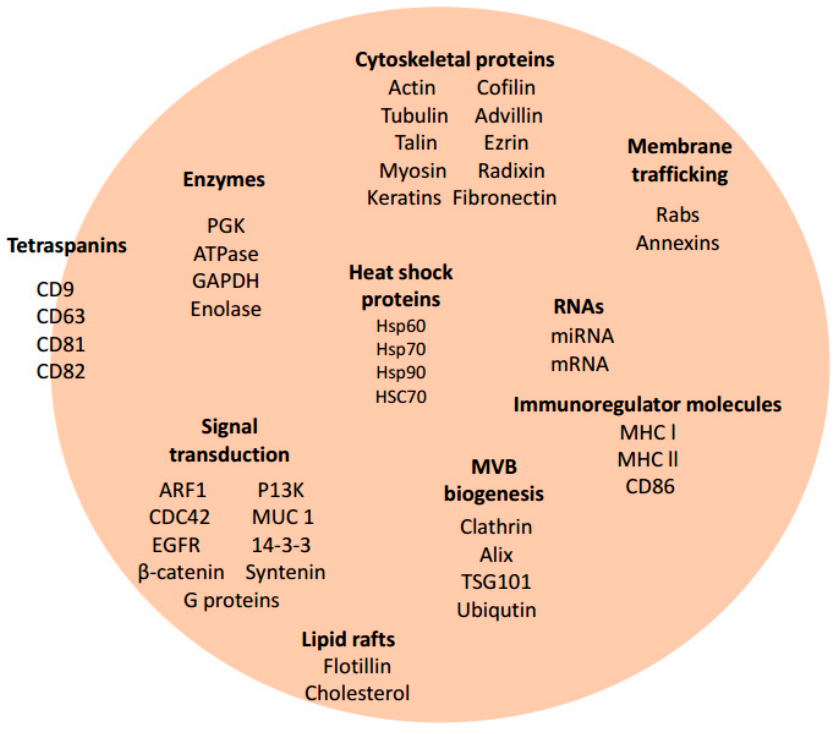
Figure 1. Composition of mammalian-derived exosomes. Proteomic, Biochemical, and Immunological investigations have identified many specific proteins and RNAs present in some exosomes. This is a limited representation of common molecules present within some mammalian-derived exosomes. Molecules illustrated here are grouped based on category function or protein class: Tetraspanins, Enzymes, Cytoskeletal proteins, Heat Shock proteins/chaperone proteins, Membrane trafficking proteins, Immunoregulator molecules, Lipid rafts, MVB biogenesis proteins, and RNAs. Some of these molecules are also found in bacteria derived-exosomes (Figure 2) and protozoan derived-exosomes (Figure 3).